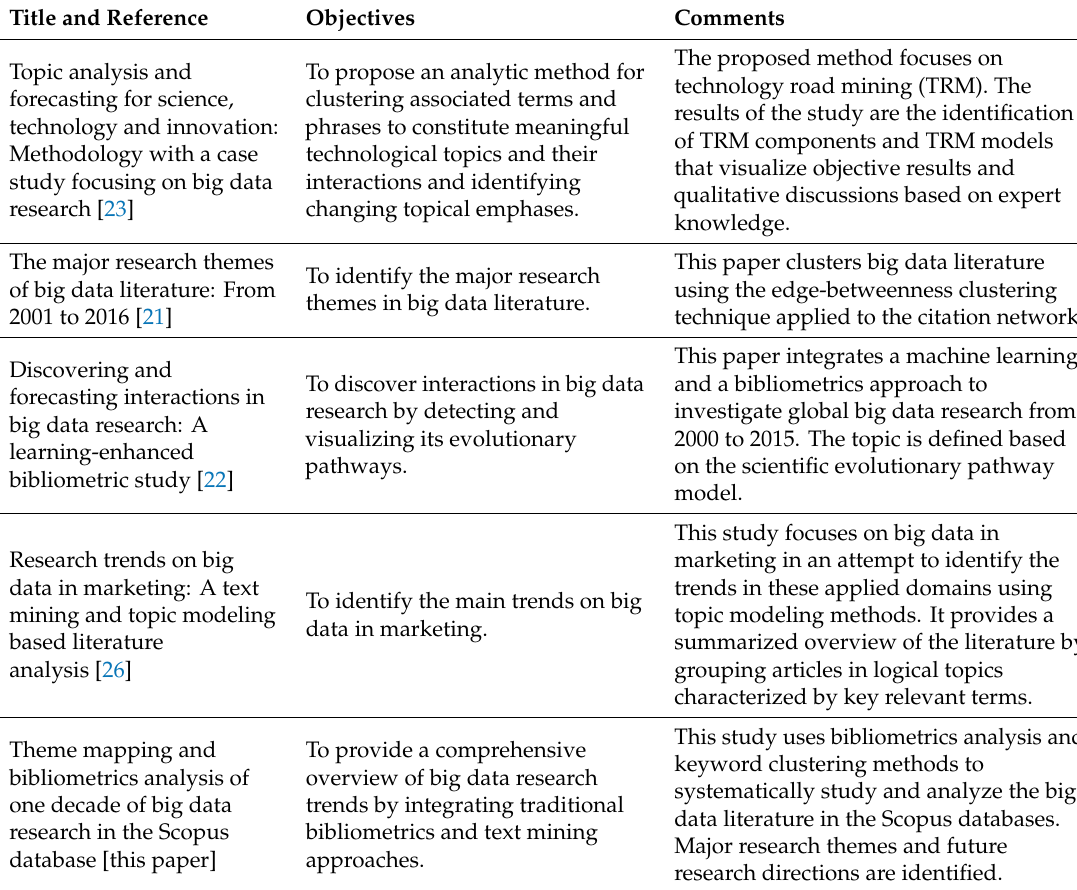
Table 7. Review of topic analysis of big data